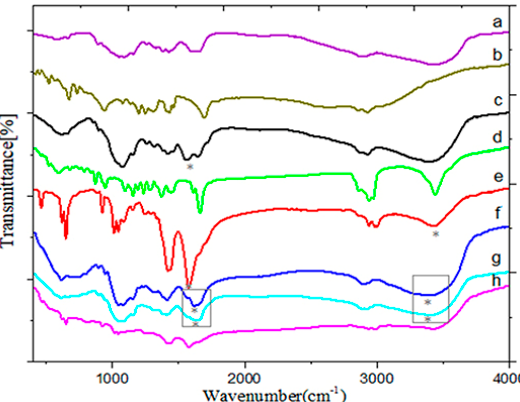
Figure Figure 1. Fourier transform infrared spectra (FT-IR) of ( a ) Chitosan (CS), ( b ) Lipoic acid (LA), ( c ) Chitosan–lipoic acid nanoparticles (CSLA-NPs), ( d ) 17 α -Methyltestosterone (MT), ( e ) 17 α -